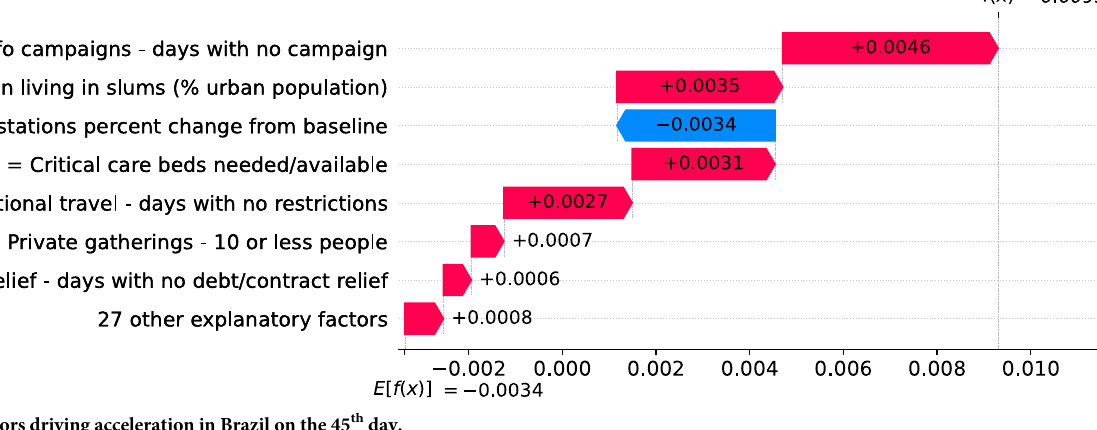
Fig 30. (Color online) factors driving acceleration in Brazil on the 45 th day.